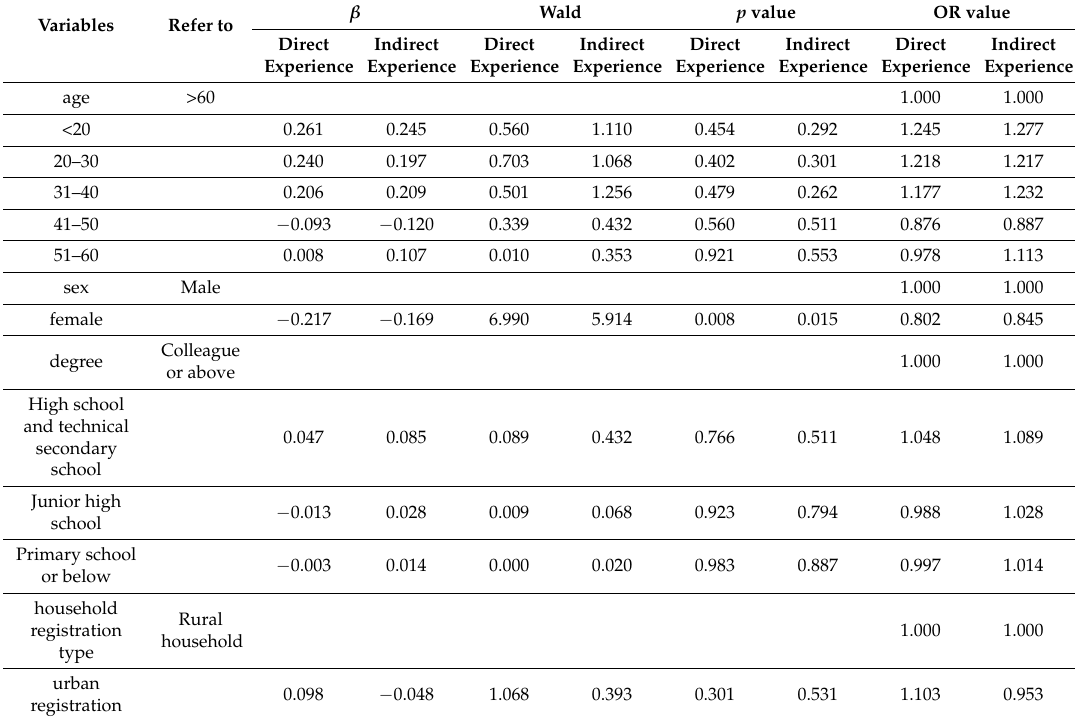
Table 4. Two types of consumers’ personal characteristic model parameter estimation